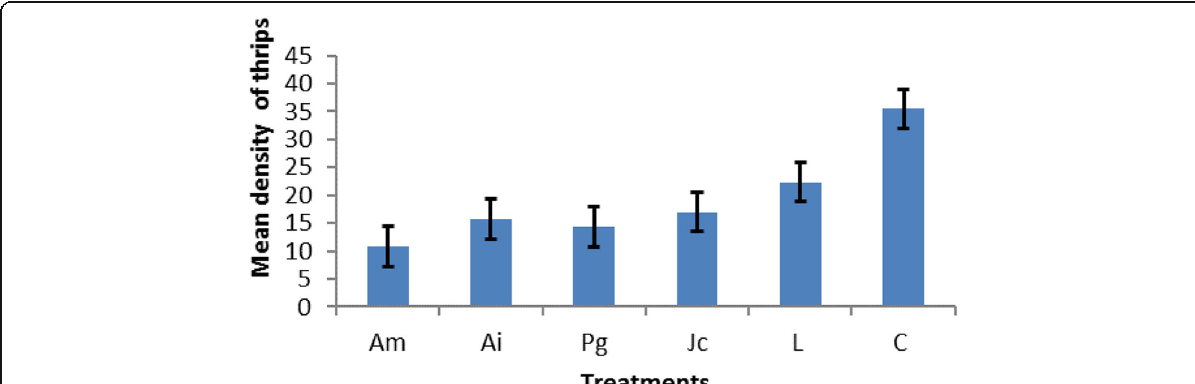
Fig. 1 Effect of treatments on the population of legume flower thrips. Mean values are the number of adult and larvae of flower thrips observed in 20 flowers sampled per plot per week during the flowering period of the cowpea from different plots treated with different botanicals. Am, plot treated with Annona muricata ; Ai, plot treated with Azadirachta indica ; Pg, plot treated with Piper guineense ; Jc, plot treated with Jatropha curcas ; L, lambdacyhalothrin; C, control (no treatment)